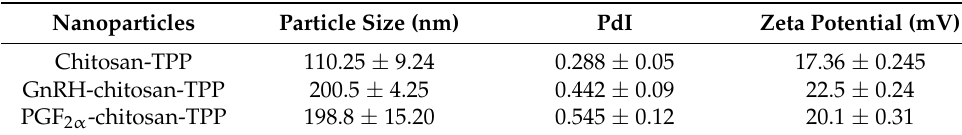
Table 1. Physicochemical properties (particle size, polydispersity index (PdI), and zeta potential) of chitosan-TPP nanoparticles, gonadotropin-releasing hormone (GnRH)-chitosan-TPP nanoparticles, and prostaglandin F 2 α (PGF 2 α )-chitosan-TPP nanoparticles.